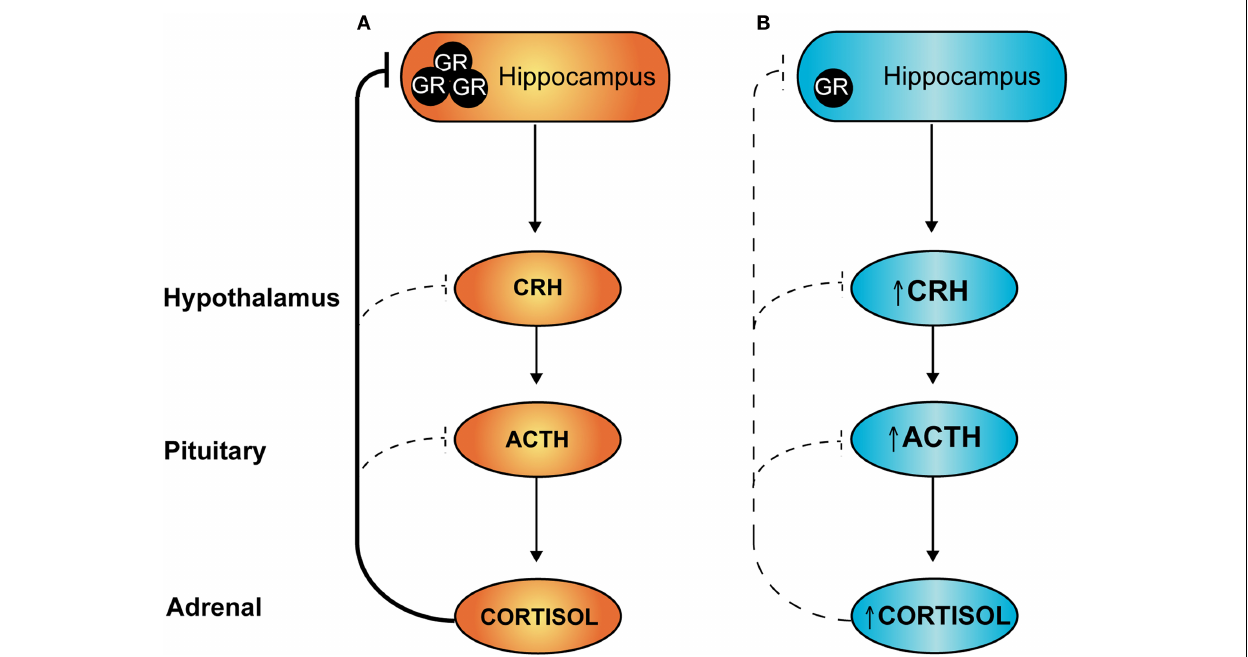
FIGURE 2 | Hypothalamic–pituitary–adrenal (HPA) axis: programming by early life stress. Under conditions of stress, sustained activation of the HPA axis is attenuated via negative feedback actions of circulating glucocorticoids. At least a component of this attenuation occurs through activation of hippocampal